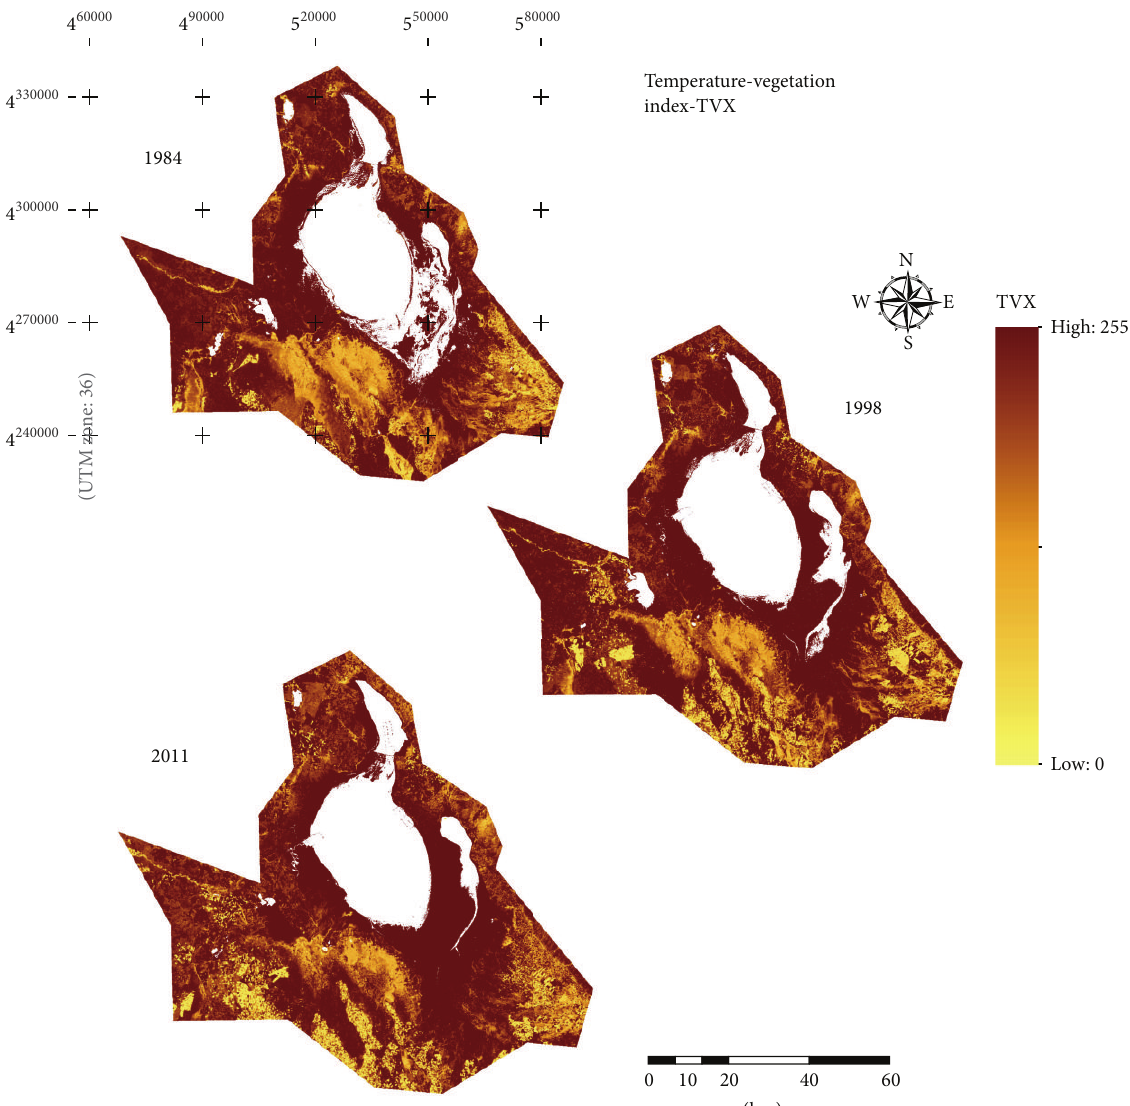
Figure 8: Multitemporal TVX index products for the